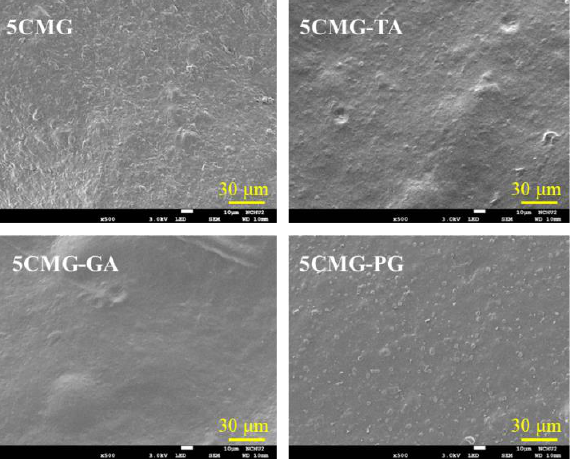
Figure 8. SEM micrographs of 5CMG samples with and without phenolic compounds.